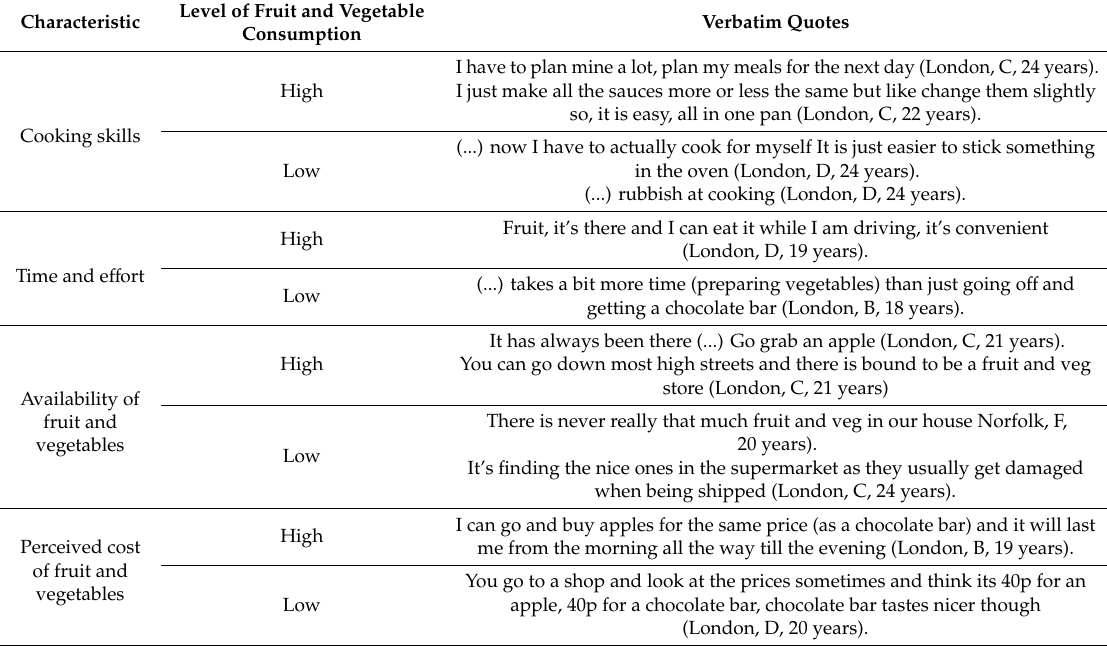
Table 3. Self-e ffi cacy for fruit and vegetable